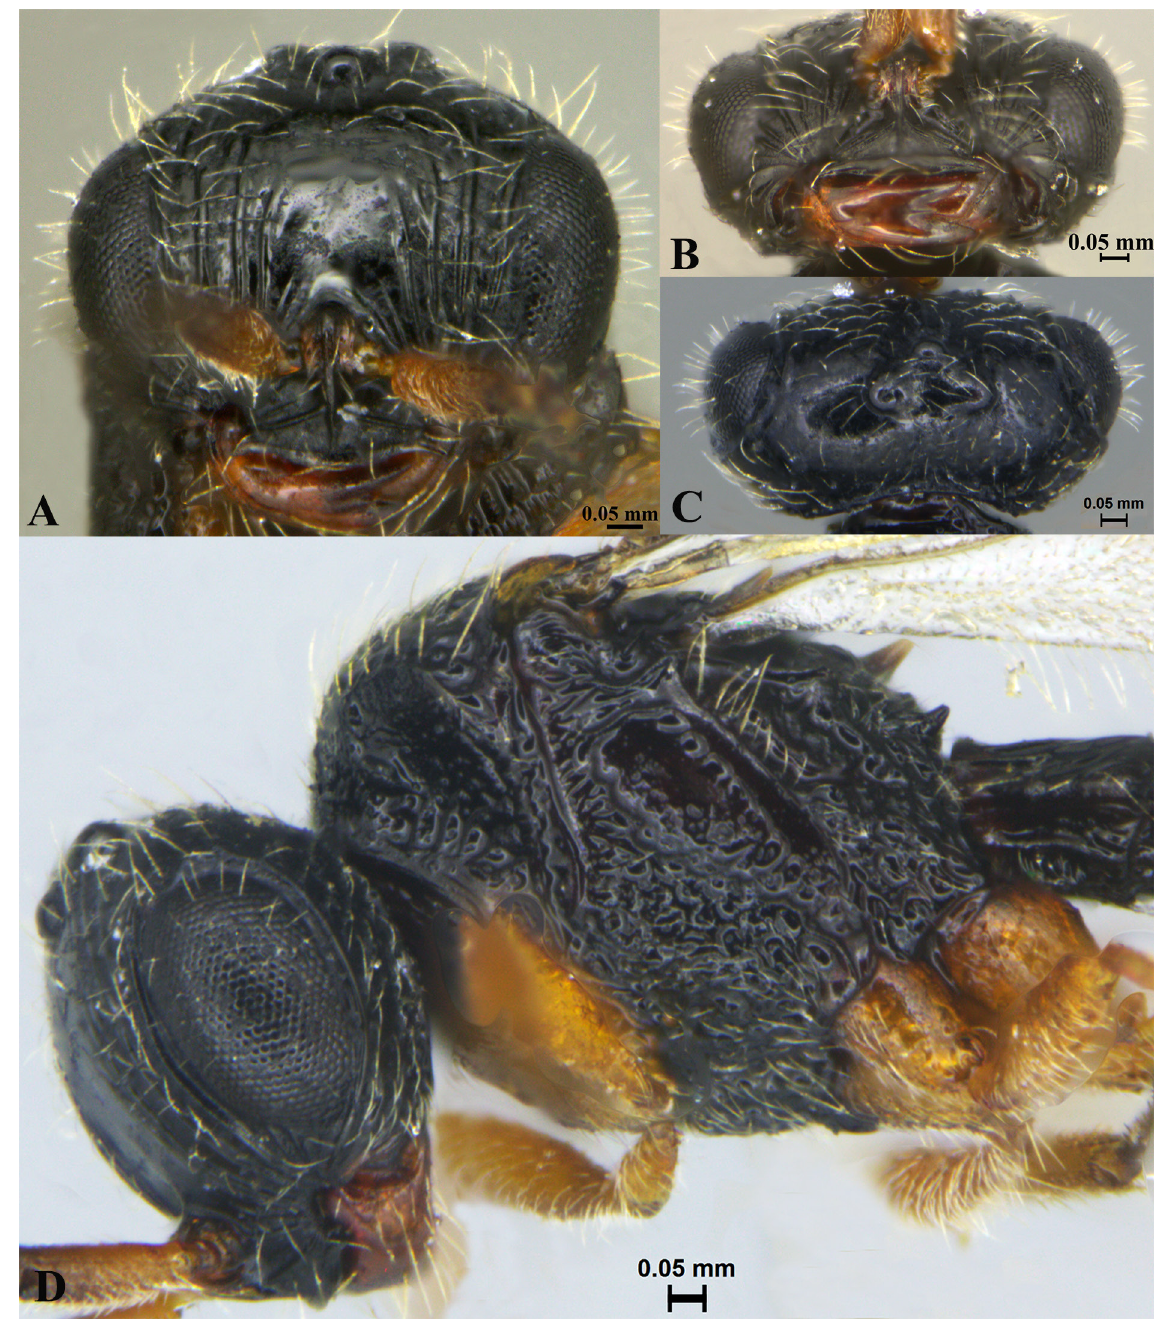
Fig. 22. Odontoscelio sp. 1. ♂ (ICAR-NBAIR P3975). A . Frons. B . Facial striae. C . Vertex. D . Head and